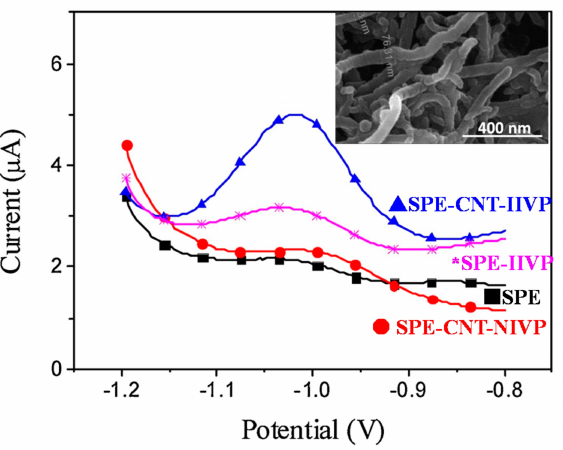
Figure 14. DPV output of 3.0 × 10 − 5 mol L − 1 Eu 3+ on bare and differently coated SPE electrodes at pH 4.7. Adapted with permission of Elsevier from